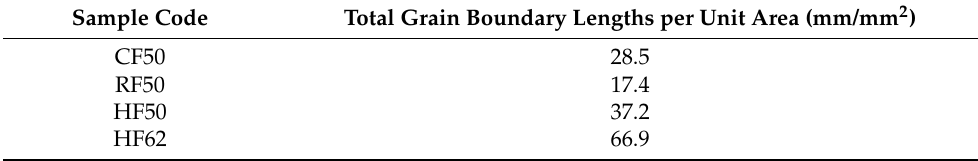
Table 6. Measured 2nd Phase Particle Size Distribution for Samples from Optical